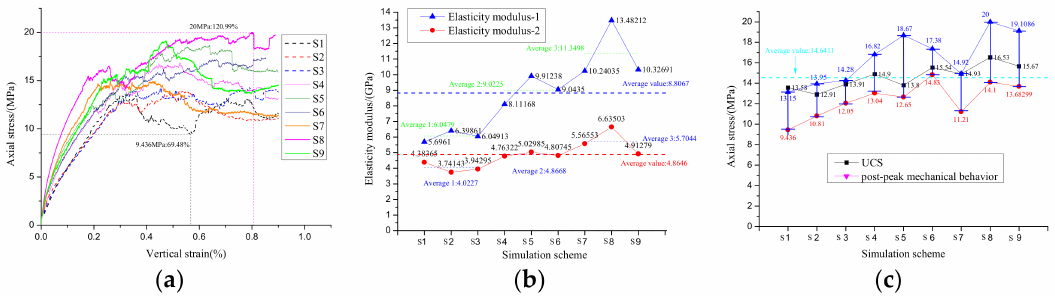
Figure 19. Mechanical characteristics of different mineral ratios: ( a ) stress–strain curve, ( b ) elastic modulus, ( c ) axial